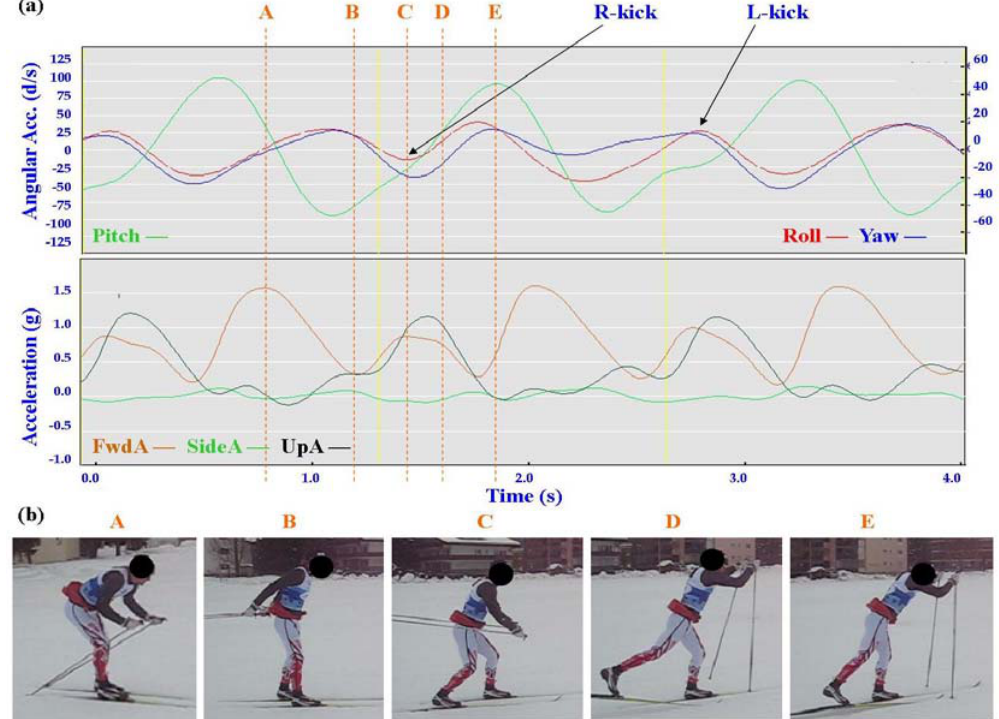
Figure 4. ( a ) Screenshot of Kick Double Poling (KDP) gyroscope and accelerometer traces against time; ( b ) KDP body position for selection points.